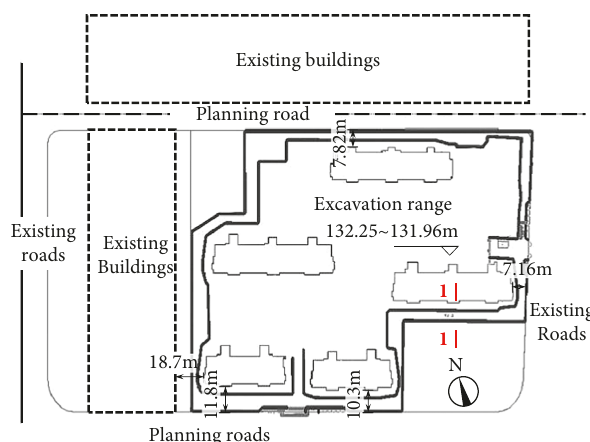
Figure 1: Surrounding environment of this excavation